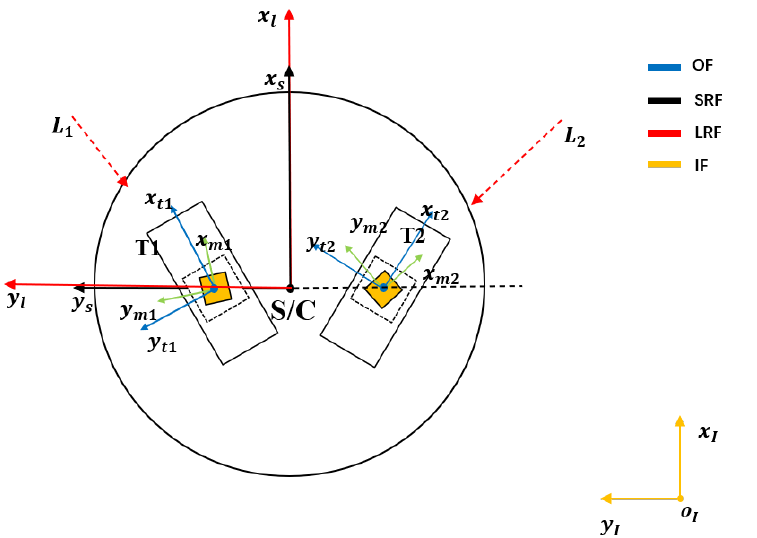
Figure 3. Coordinate system. OF, SRF, LRF, IF represent the optical assembly frame, S/C rotation reference frame, LOS reference frame, and inertial frame,